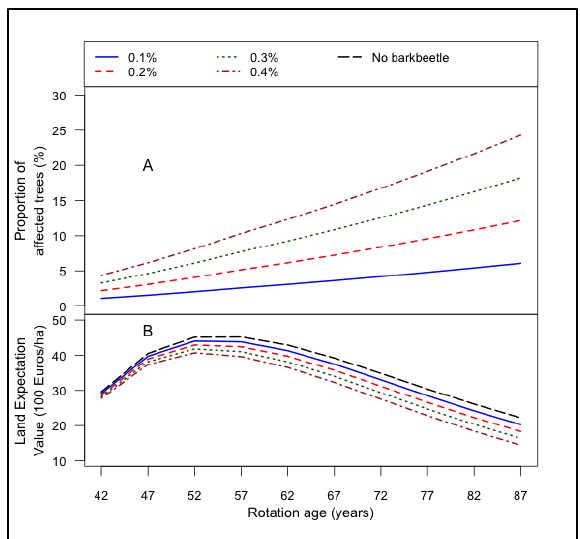
Figure 2. Percentage of standing volumes affected by bark beetle damage at final felling in Norway spruce stand in southern Sweden with indicated annual increases in damage levels ( A ). Changes in land expectation values with rotation age, with indicated annual increases in levels of bark beetle damage in Norway spruce stand in southern Sweden ( B ).